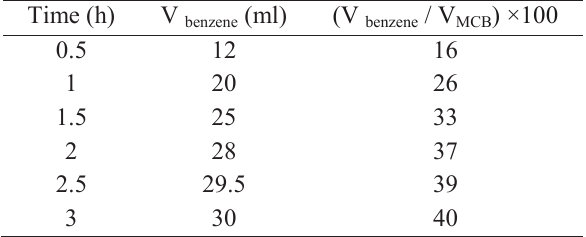
Catalytic test results for C2